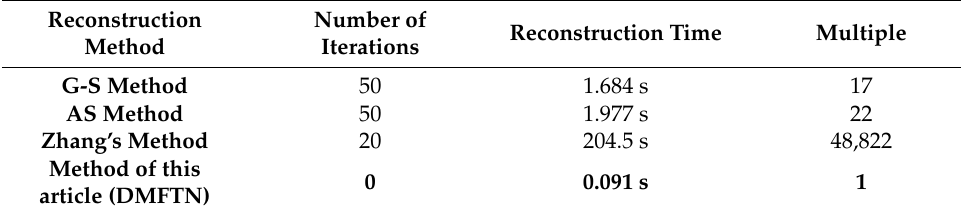
Table 3. Comparison of reconstruction time of four methods.